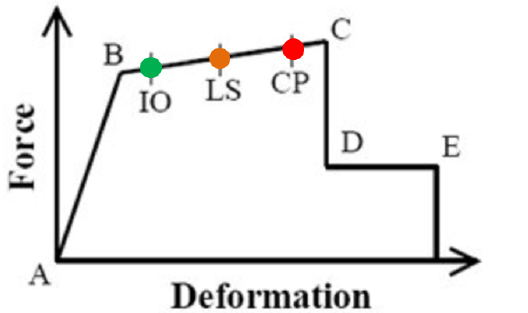
Figure 3. Typical pushover curve with performance levels .